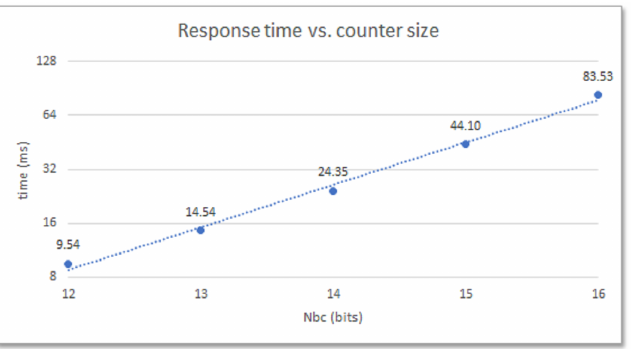
Figure 5. Semi-logarithmic representation of the response time versus counter size for a 480-RO PUF on a Pynq Z2 development board.